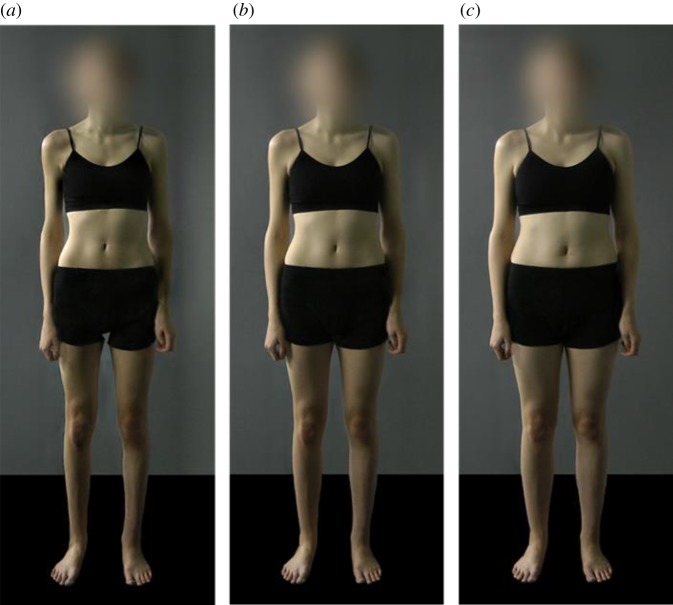
Examples of stimuli used: (a) ‘underweight'; (b) ‘neither over- nor underweight'; (c) ‘overweight'.